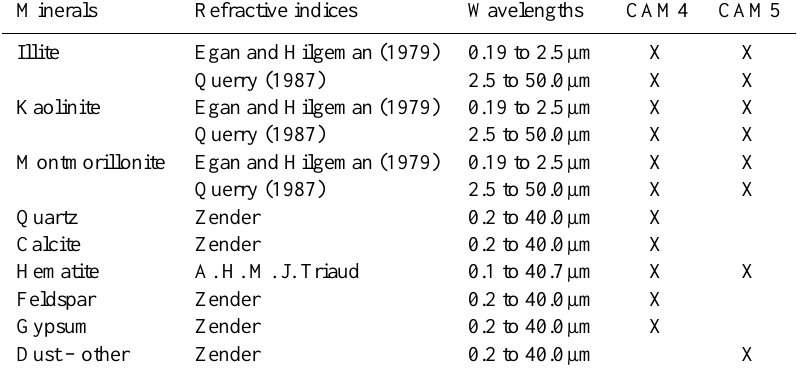
Table 3. Refractive indices of minerals used, wavelengths of refractive indices and references for input into CAM4 and CAM5. Refractive indices specified as “Zender” are a Maxwell–Garnet internal mixture of 48% quartz, 25% illite, 25% montmorillonite and 2% calcite by volume. These were used primarily to simplify the comparison between CAM4 and CAM5. Longwave optics from CAM3 (Mahowald et al., 2006) were substituted for CAM4 as a solver was not available to calculate the LW absorption coefficients from the refractive indices.